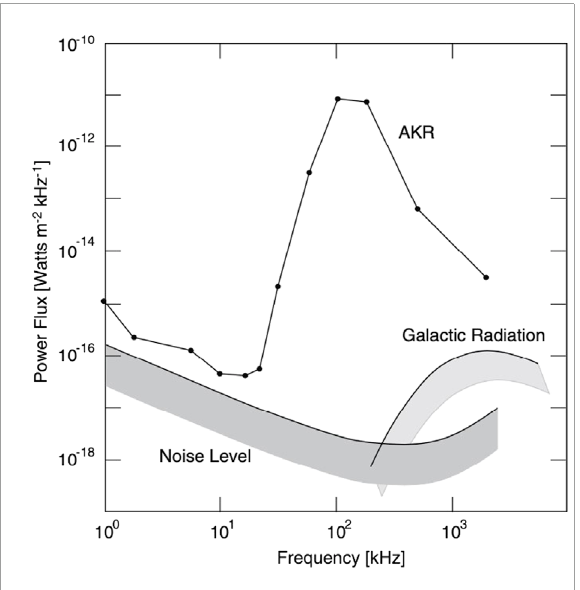
FIGURE 1 The spectral intensity of Gurnett (1974) first observation and identification of auroral kilometric radiation [adapted in this form from (Treumann, 2006)].